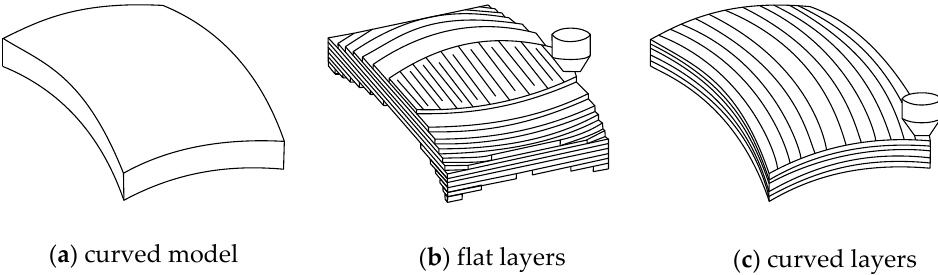
Figure 16. Comparison of flat and curved layer manufacturing: ( a ) curved part to be manufactured ( b ) part sliced with classical flat layers ( c ) part sliced with curved layers (based on the work in [92]).